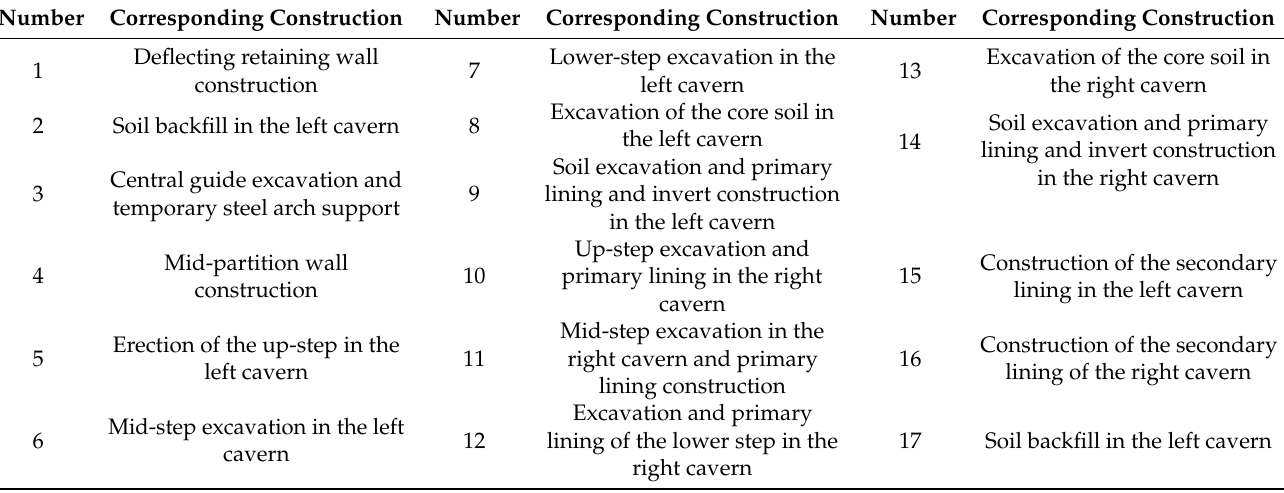
Table 2. The main construction and its construction sequence.